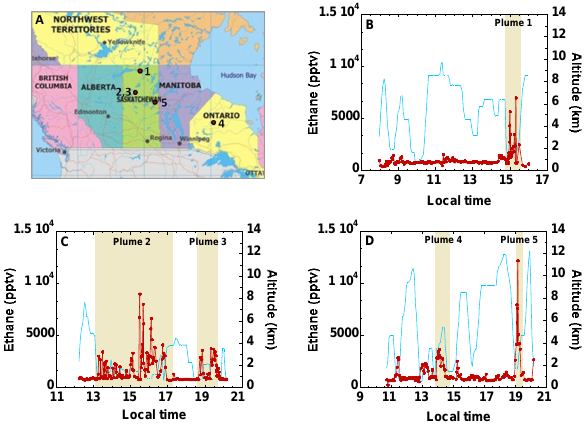
Fig. 1. (a) Approximate locations of five fire plumes that were Figure 1. (a) Approximate locations of five fire plumes that were sampled in 2008 during the sampled in 2008 during the summer phase of ARCTAS on 29 June summer phase of ARCTAS on June 29 (Plume 1), July 1 (Plumes 2 and 3), and July 4 (Plumes 4 (Plume 1), 1 July (Plumes 2 and 3), and 4 July (Plumes 4 and 5). The plume locations are based on the maximum 1 s CO measure- and 5). The plume locations are based on the maximum 1 s CO measurement for each plume ment for each plume encounter, even though they were sampled encounter, even though they were sampled over a larger area (see Table 2). (b-d) Time series of over a larger area (see Table 2). (b–d) Time series of ethane (red cir- ethane (red circles) and altitude (blue line) for (b) Flight 17; (c) Flight 18; and (d) Flight 19, cles) and altitude (blue line) for (b) Flight 17; (c) Flight 18; and (d) showing the duration of each plume encounter (shaded area). Flight 19, showing the duration of each plume encounter (shaded